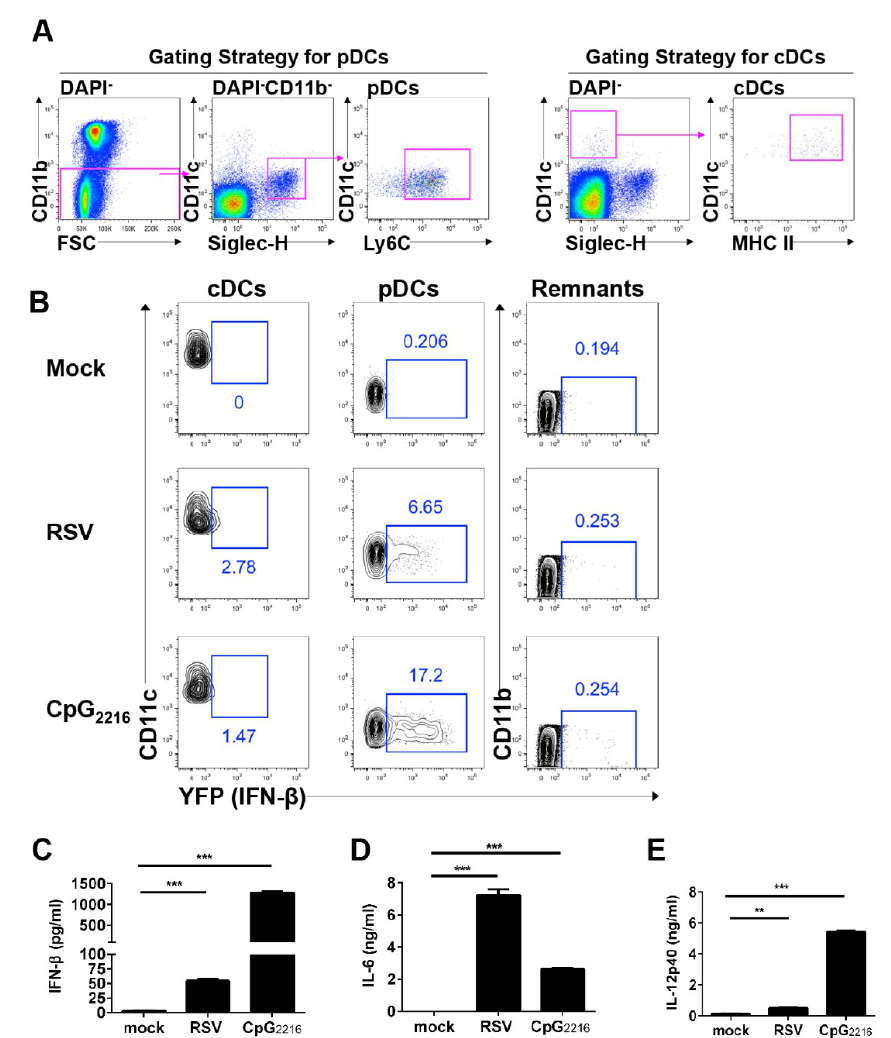
infected BM cells secreted interferon-β and proinflammatory cytokines (Figure 1C–E). Taken together, pDCs are the predominant interferon-β producing cell type during RSV infection in vitro.